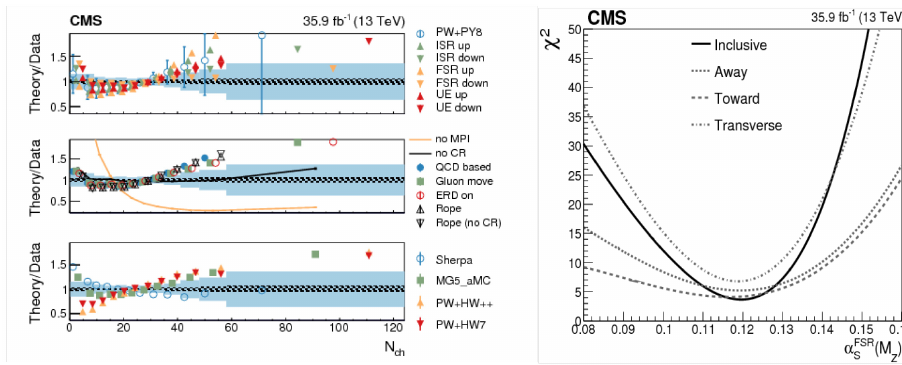
Fig. 7. The normalized differential cross section as a function of N ch compared to predictions of different models (left), scan of the simulation